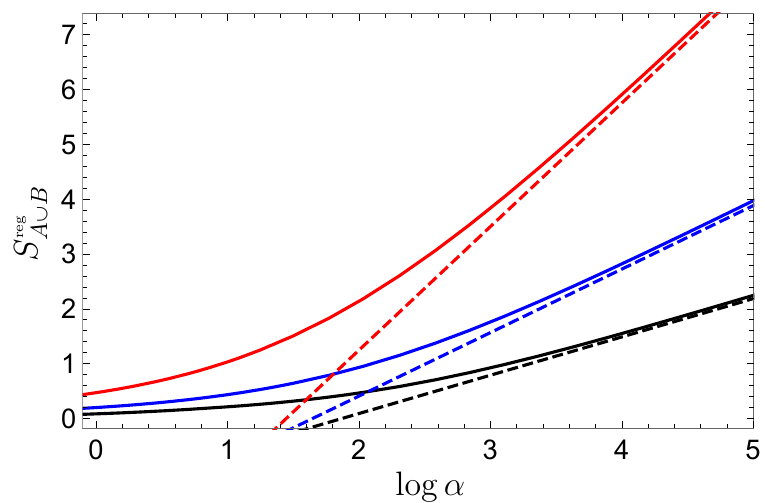
(in units of V 2 =G ) as N A [ B =T 2 = 0 (black curves), B